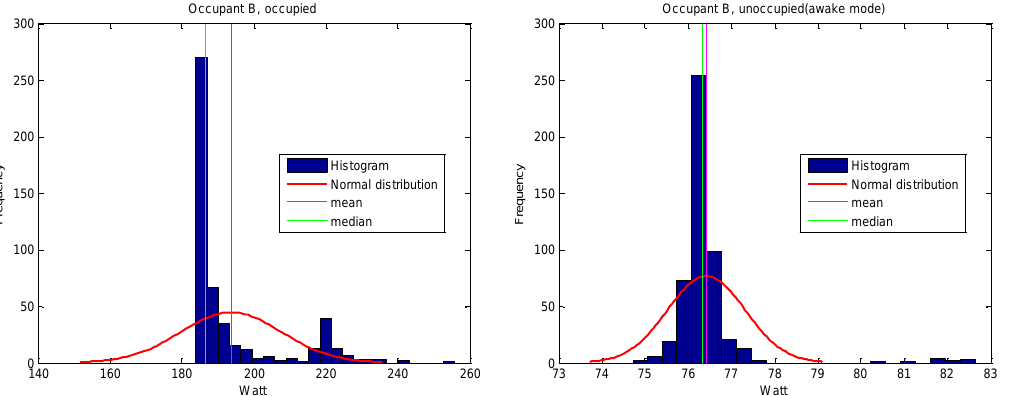
Figure 14. Occupant A, representative value of plug load.